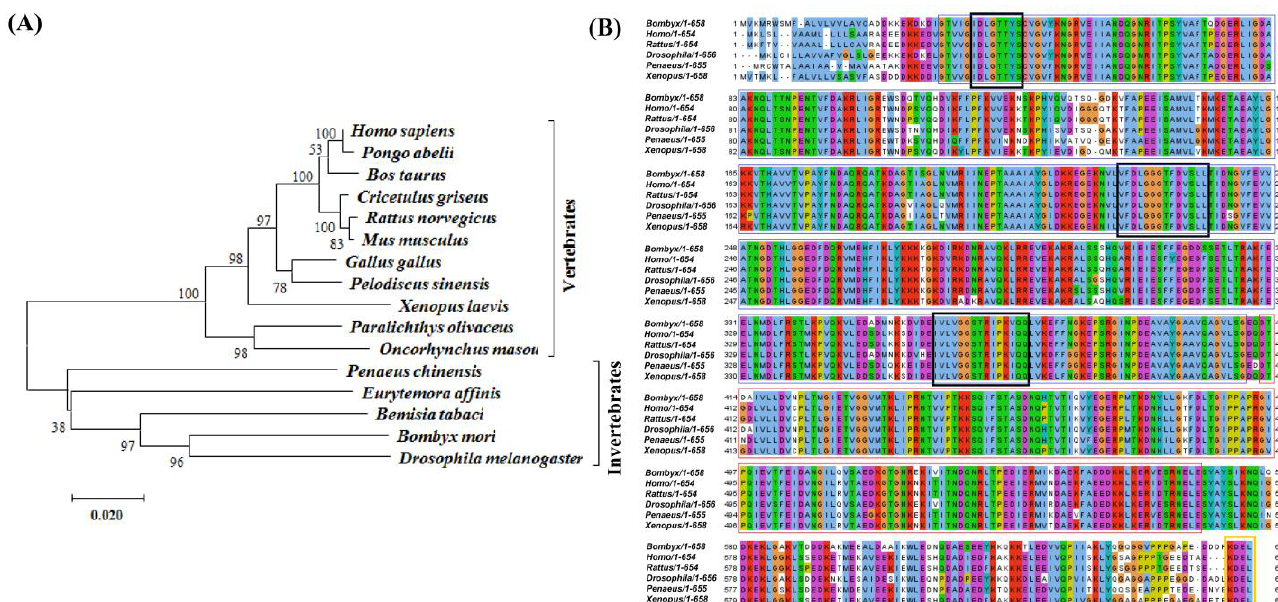
Figure 2. Phylogenetic analysis and sequence alignment of BmGRP78 protein with its homologs from invertebrate and vertebrate species. ( A ) The deduced amino acid sequences were aligned, and a phylogenetic tree was constructed by using MEGA (v7.0) and the neighbor-joining method. Homo